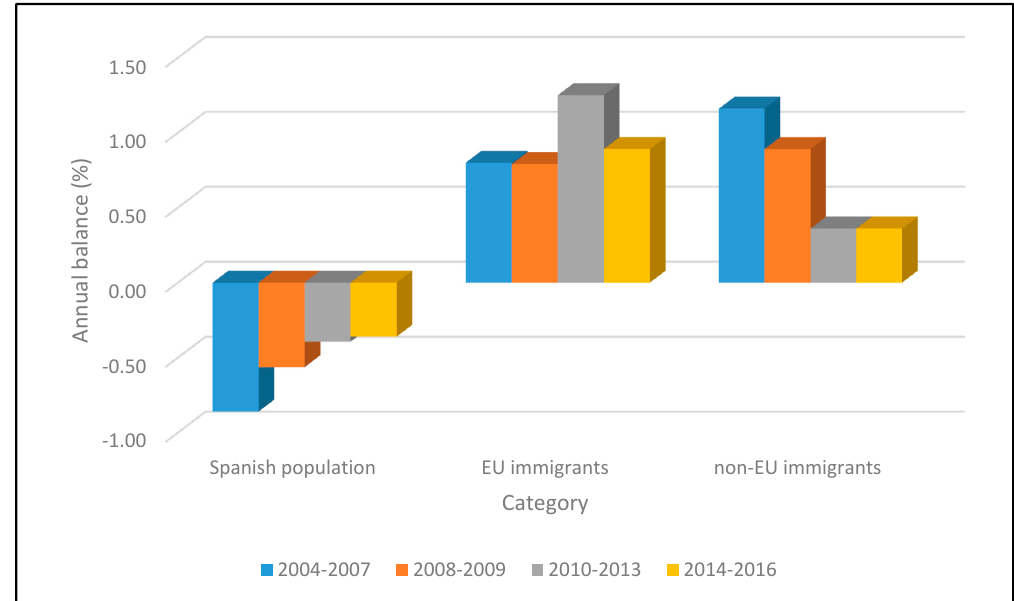
Figure 5. Migration balance according to nationality in Cabanyal, 2004–2016.